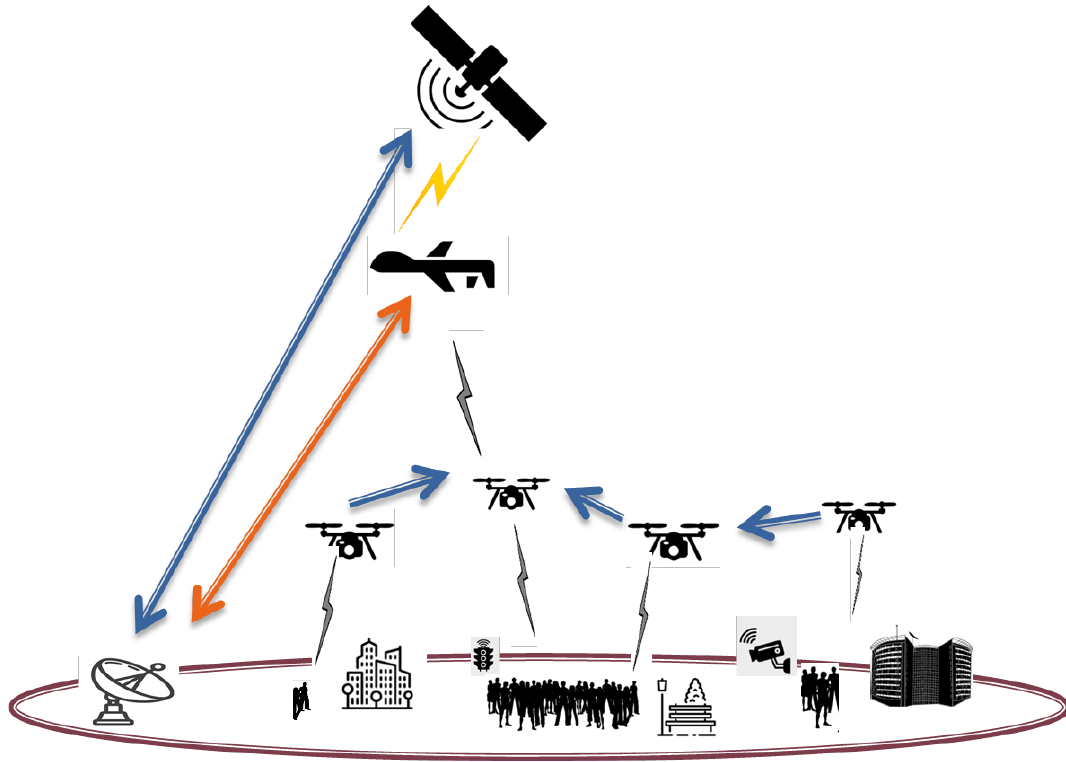
Figure 4. An example of satellite